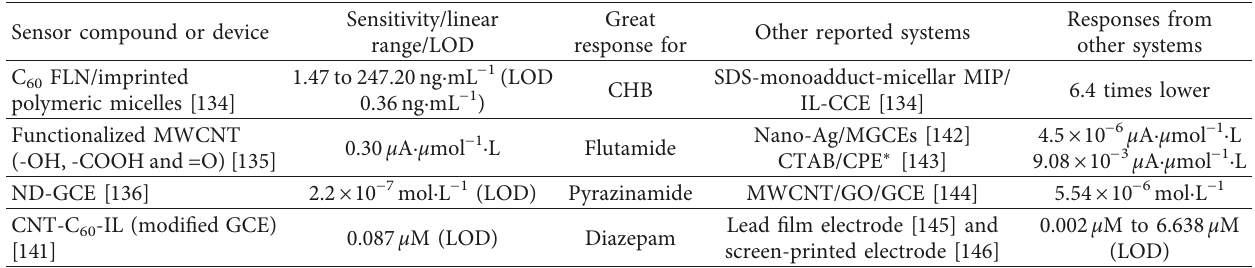
Table 6: Comparison between some of the drugs sensor systems described in this review and those already reported in the literature. Sensor compound or